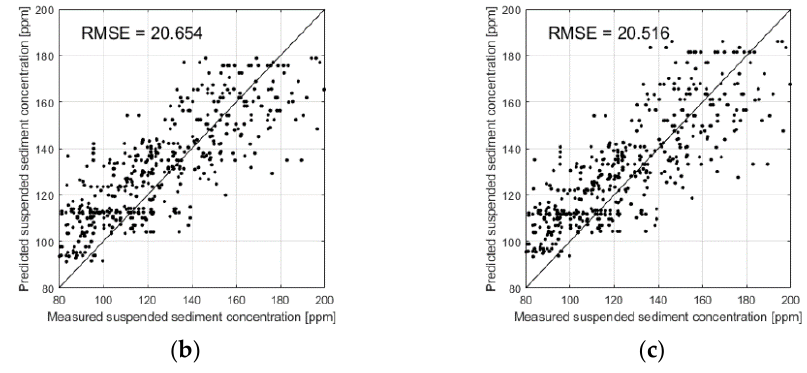
Figure 13. Concentration estimated using the predicted turbidity by the developed model: ( a ) power-law, ( b ) second-order polynomial, and ( c ) first-order polynomial.